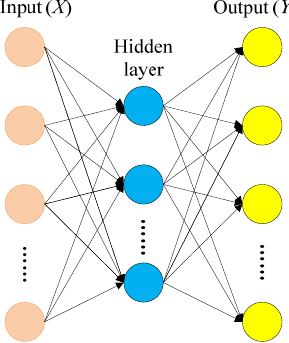
Figure 7. Neural networks of the stacked denoising auto ‐ encoder (SDAE).